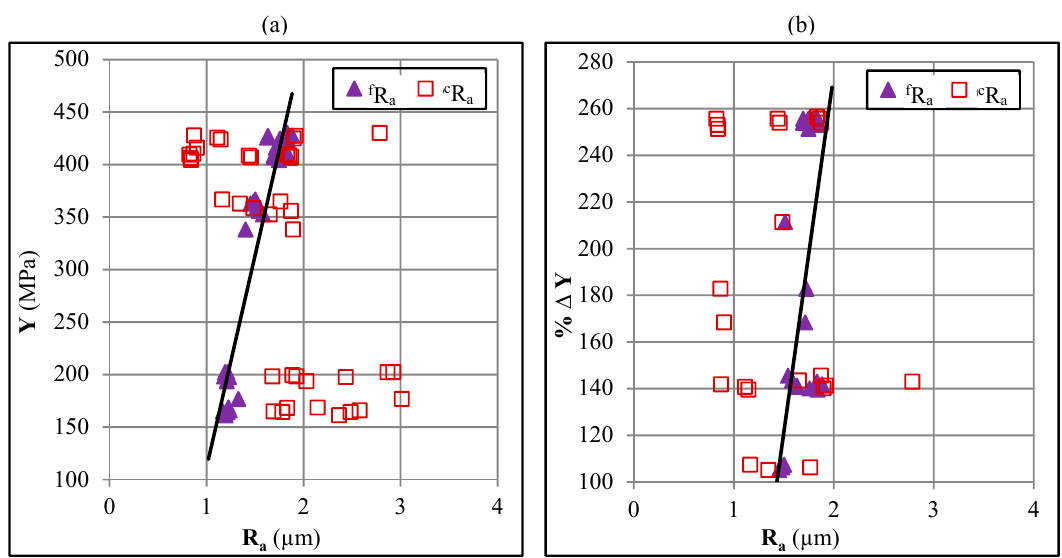
Figure 5. Correlations between the mean roughness and post-forming yield strength: ( a ) Yield strength and ( b ) % increase in yield strength.